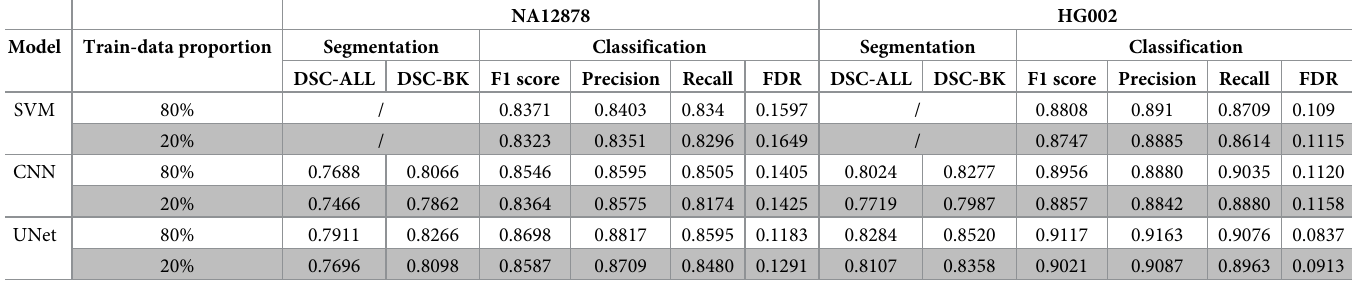
Table 3. Model-level performance on the real dataset. 5-fold cross-validations were performed on NA12878 and HG002 using a screening window length of 400 bp. The average result of 5-repeat runs is reported to reduce the effect of the randomness of GPU